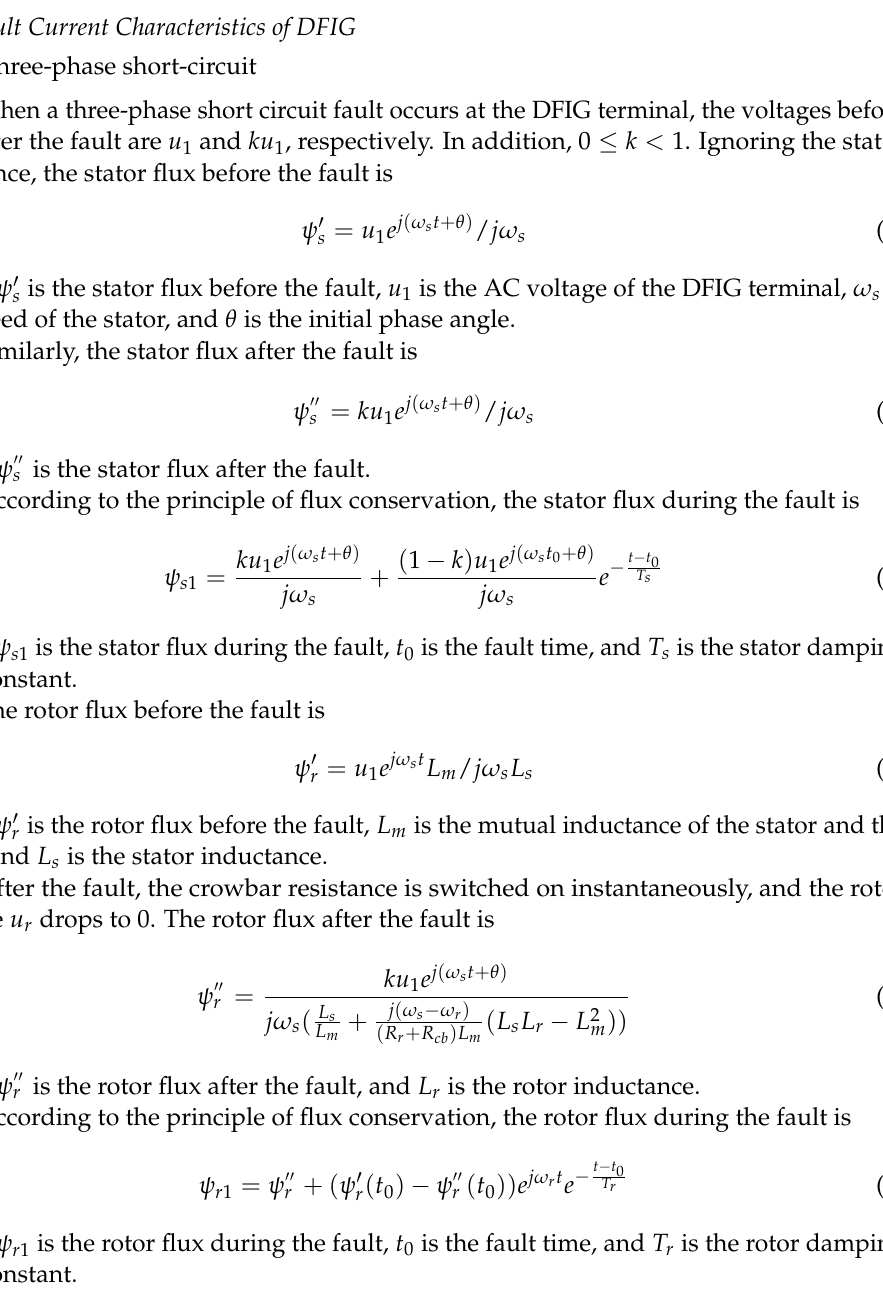
Figure 1. Topology of MMC-HVDC with offshore wind farms.